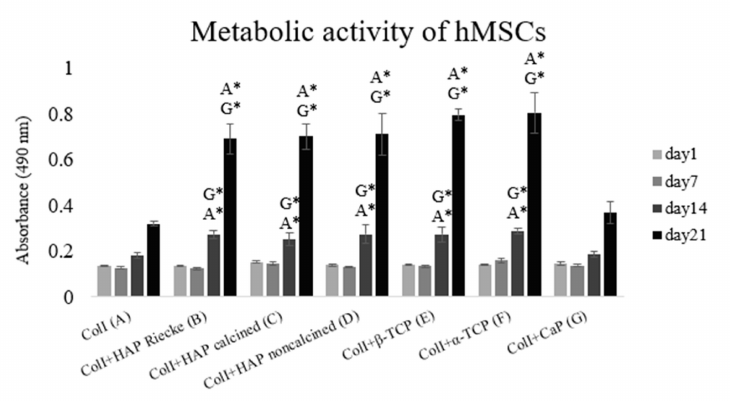
Figure 2. Level of cellular metabolic activity evaluated by MTS test. Cells seeded on: Coll ( A ), ColI+HAP Reicke ( B ), ColI+HAP calcined ( C ), ColI+HAP noncalcined ( D ), ColI+ β -TCP ( E ), ColI+ α - TCP ( F ) and ColI+CapolyP ( G ). Statistical significance marked with the name of group and asterisk sign for p < 0.01.